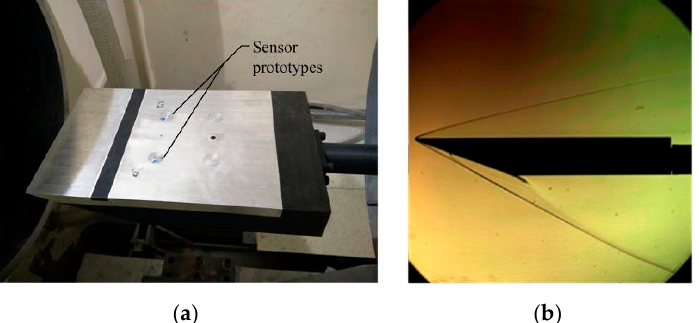
Figure 11. The test facility and Schlieren photo for sensor prototypes.( a ) The test facility;( b ) Schlieren The test facility and Schlieren photo for sensor photo. Table 3. The detailed flow field parameters of the wind tunnel used for sensor validation.